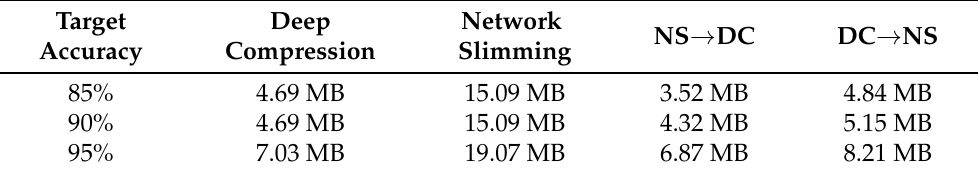
DC and DC NS for → →